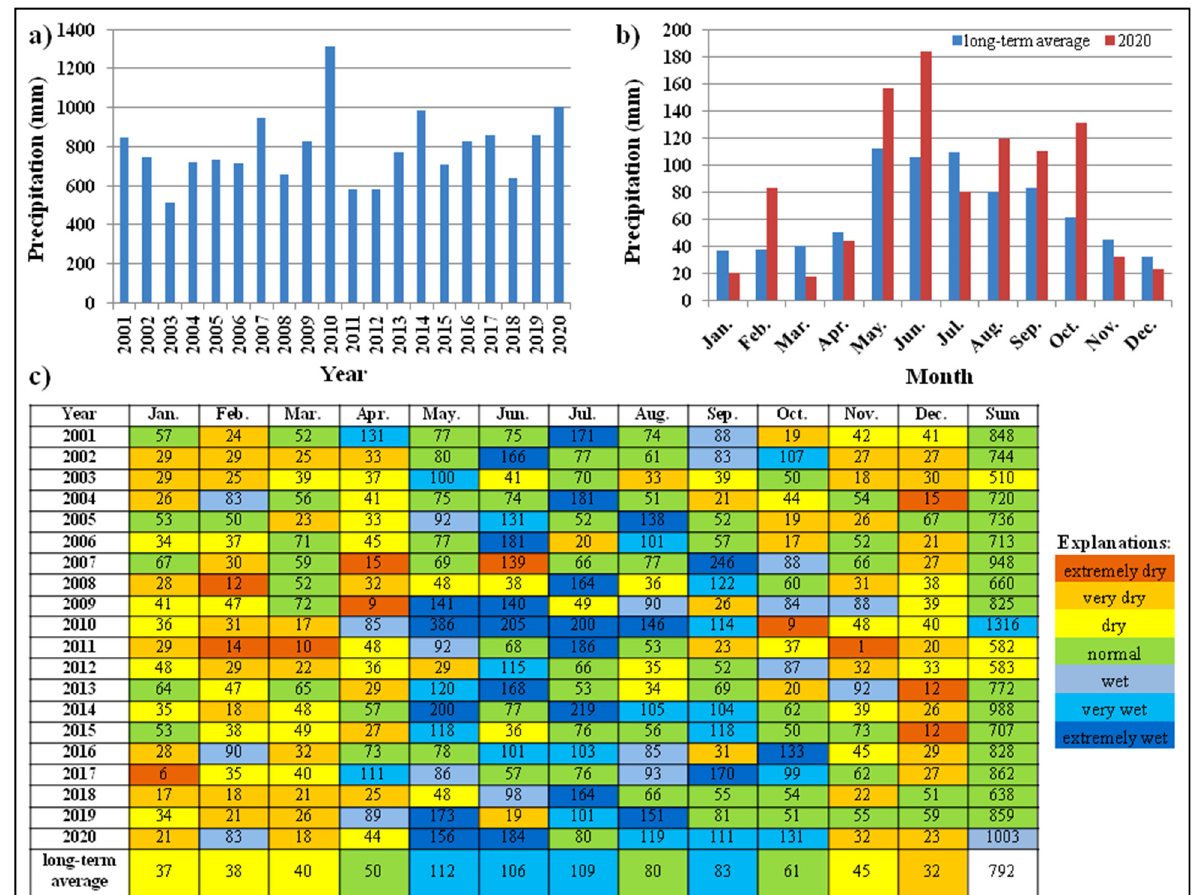
Figure 2. The characteristics of the precipitation conditions: ( a ) average annual precipitation in 2001–2020; ( b ) average monthly precipitation from the multi-year period 2001–2020 and in 2020; ( c ) classification of precipitation conditions on the basis of Relative Precipitation Index (RPI) for the months and years.